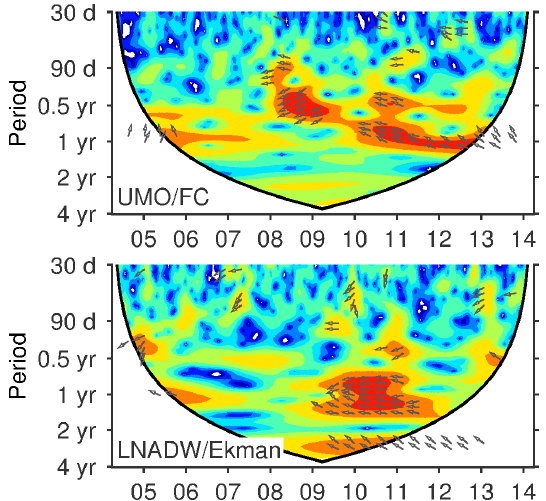
Figure 11. (a) Cross-wavelet transform between the FC and UMO shows high power (red) with a fixed-phase relationship since 2007 at periods between 60 and 400days. (b) Cross-wavelet transform between Ekman and LNADW shows high power primarily at annual periods during the 2009–2010 events, as well as sub-annual from 50–150days in 2005, 2011, and 2013. (Arrows pointing to the left indicate out-of-phase relationship or anti-correlation, and are only shown when the relationship is significant. Deviations from 180 ◦ indicate a lag or phase